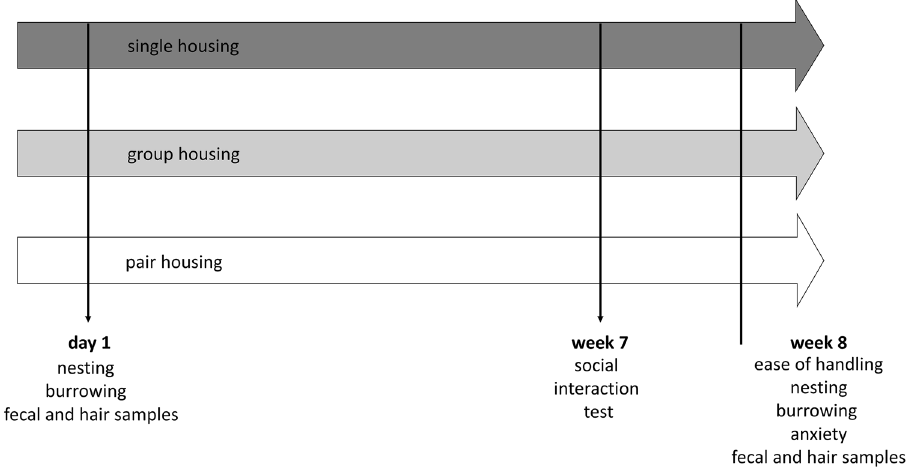
Figure 2. Testing schedule. Indicators of well-being were measured in single-, group-, and pair-housed mice on day 1, week 7, and week 8 after transfer to the indicated housing systems.